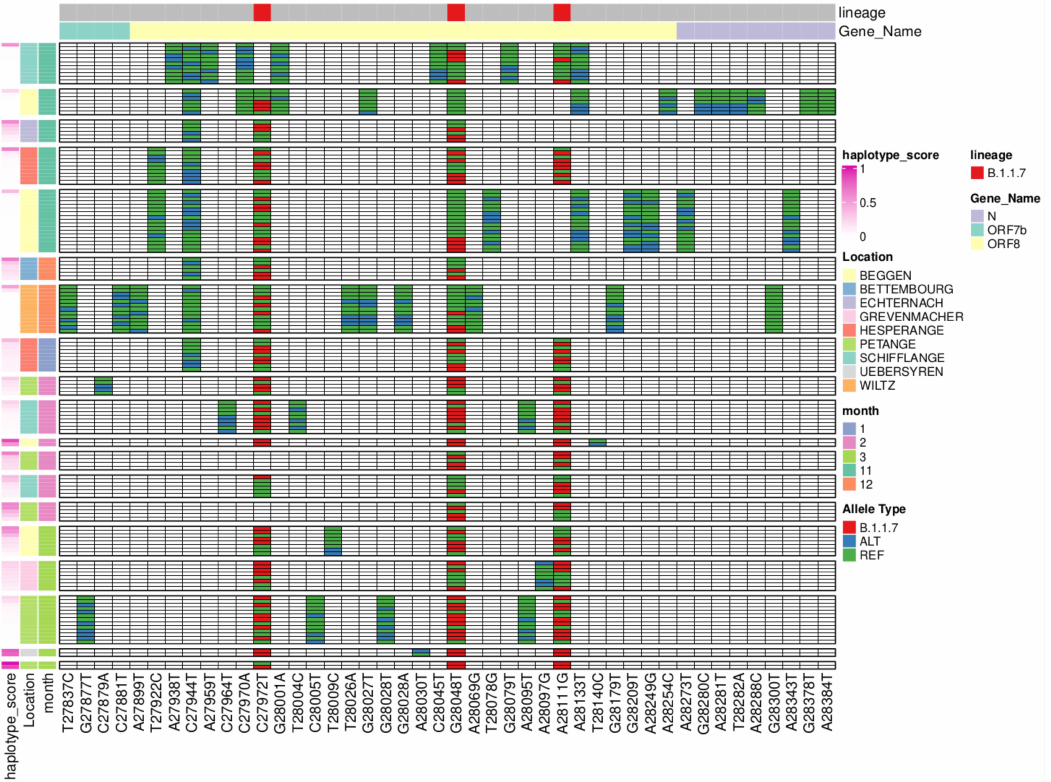
Figure 5. Individual haplotypes (rows) for genomic regions between position 27,837 and 28,384 grouped by sample. Colors indicate the respective allele for each mutation present (columns) with reference alleles in green, alternative alleles in blue, and alternative alleles corresponding to B.1.1.7 signature mutations in red. The haplotype score of gretel is shown as a row annotation, as well as the month and location of sampling. Samples are arranged by date, and haplotypes within one sample are sorted by haplotype score. Column annotations highlight the B.1.1.7 signature mutations within the genomic region and the gene name. Signature mutations highlighted in this figure: Q27*, R52I and Y73C (all